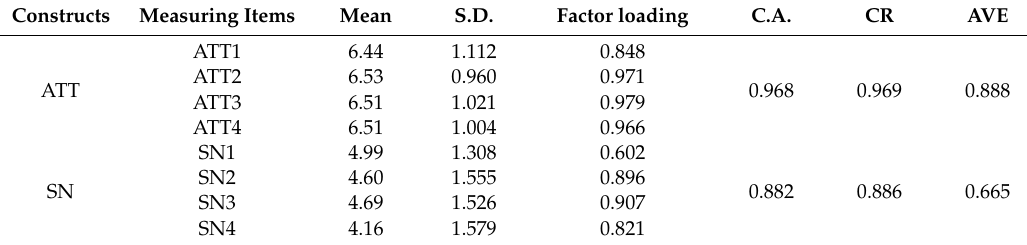
Table 3. Reliability and convergence validity test